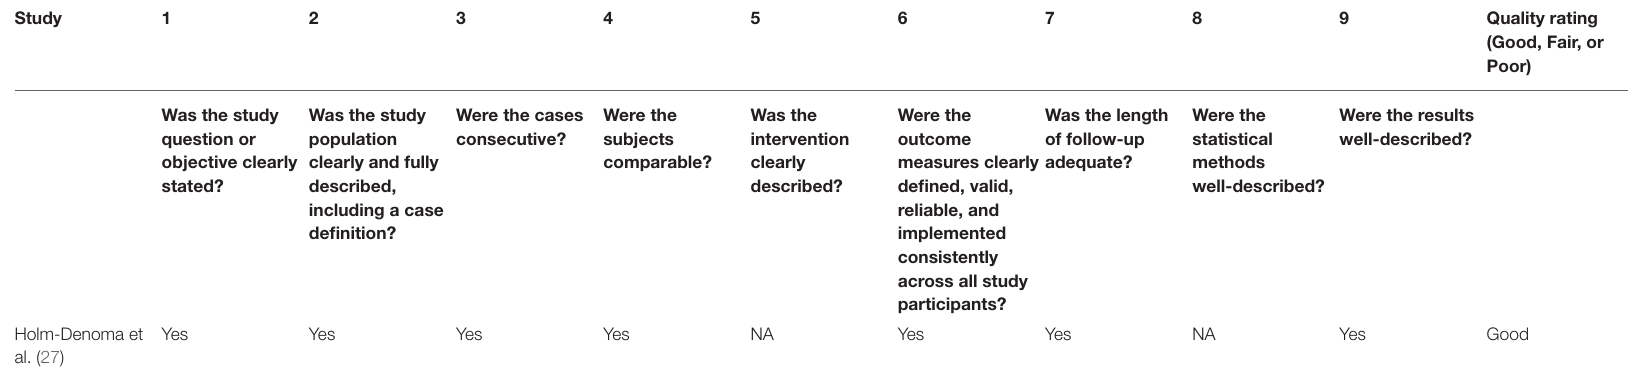
TABLE 3 | Quality of reporting of the included case series study according to the Quality Assessment Tool for Case Series